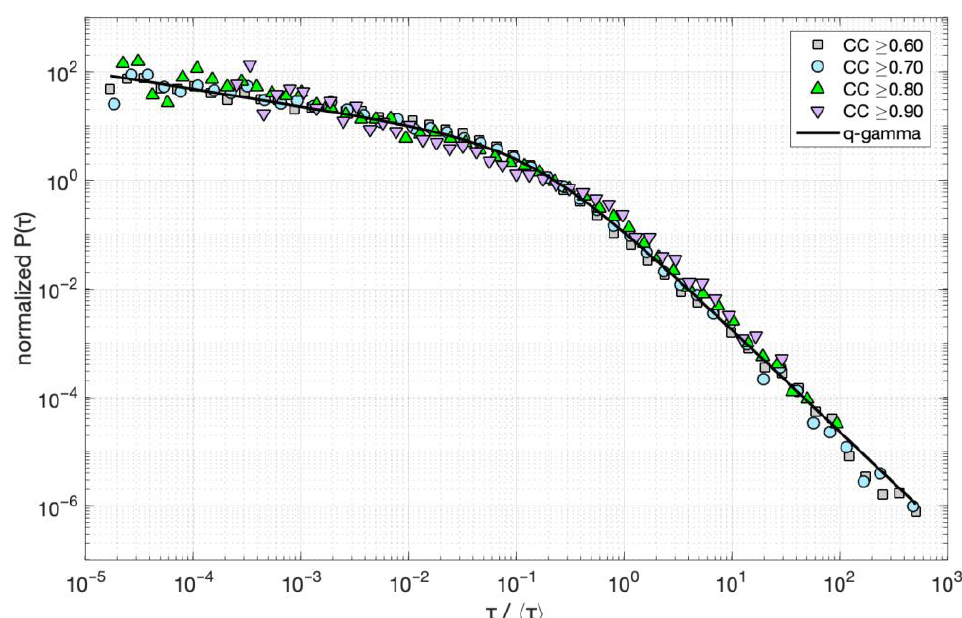
Figure 13. Normalized probability densities p ( τ ) of the rescaled inter-event times τ (symbols) for the stacked inter-event times of all multiplet families with N ≥ 10 and various values of the correlation coefficient (CC) between the multiplets and the master event. The solid line represents the q -generalized gamma function (Equation (3)) fitted to the data, with parameter values C = 2.5, γ = 0.68, τ 0 = 0.1, and q = 1.64.